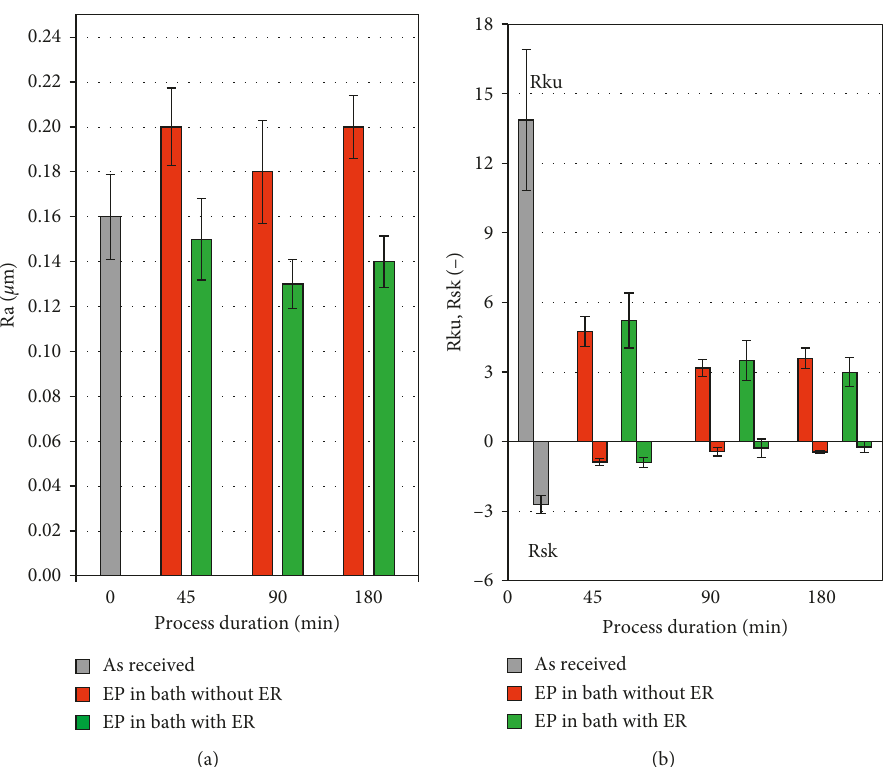
Figure 3: Comparison of the changes in surface roughness parameters of samples “as received” and samples after EP in a bath without ER and with ER (EP process parameters: t mean deviation of the assessed profile Ra and (b) skewness of the surface roughness profile Rsk and kurtosis of the profile Rku.